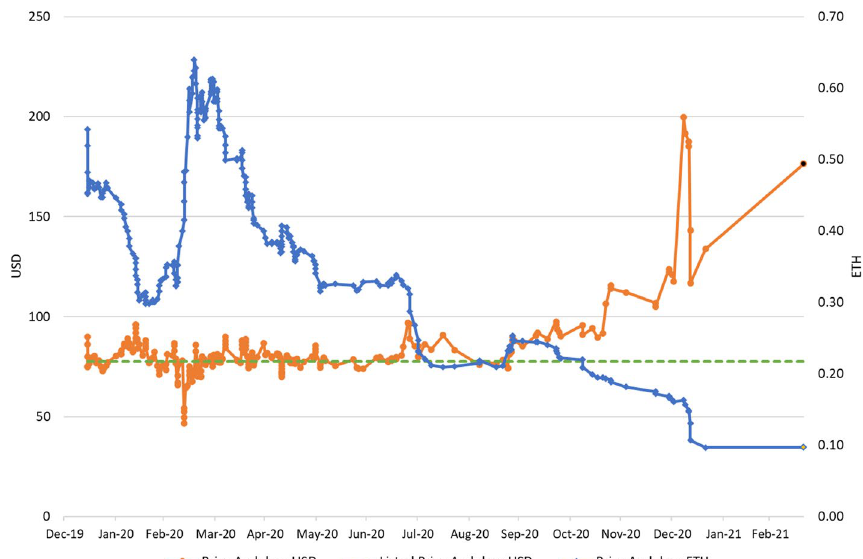
Fig. 12 Price (in USD and ETH) of 5942 Audubon Road Detroit MI. Each dot represents one transaction. Last colored dot is ask price on Uniswap